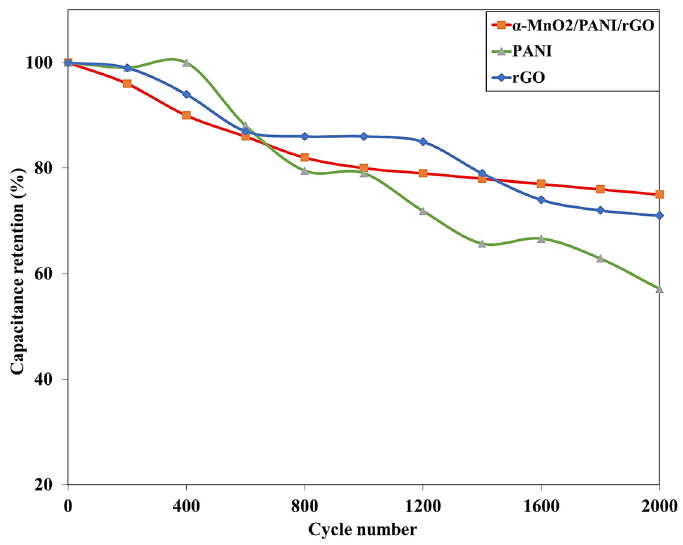
Figure 10. Cyclic stability of PANI, rGO and α -MnO 2 /PANI/rGO nanocomposite.